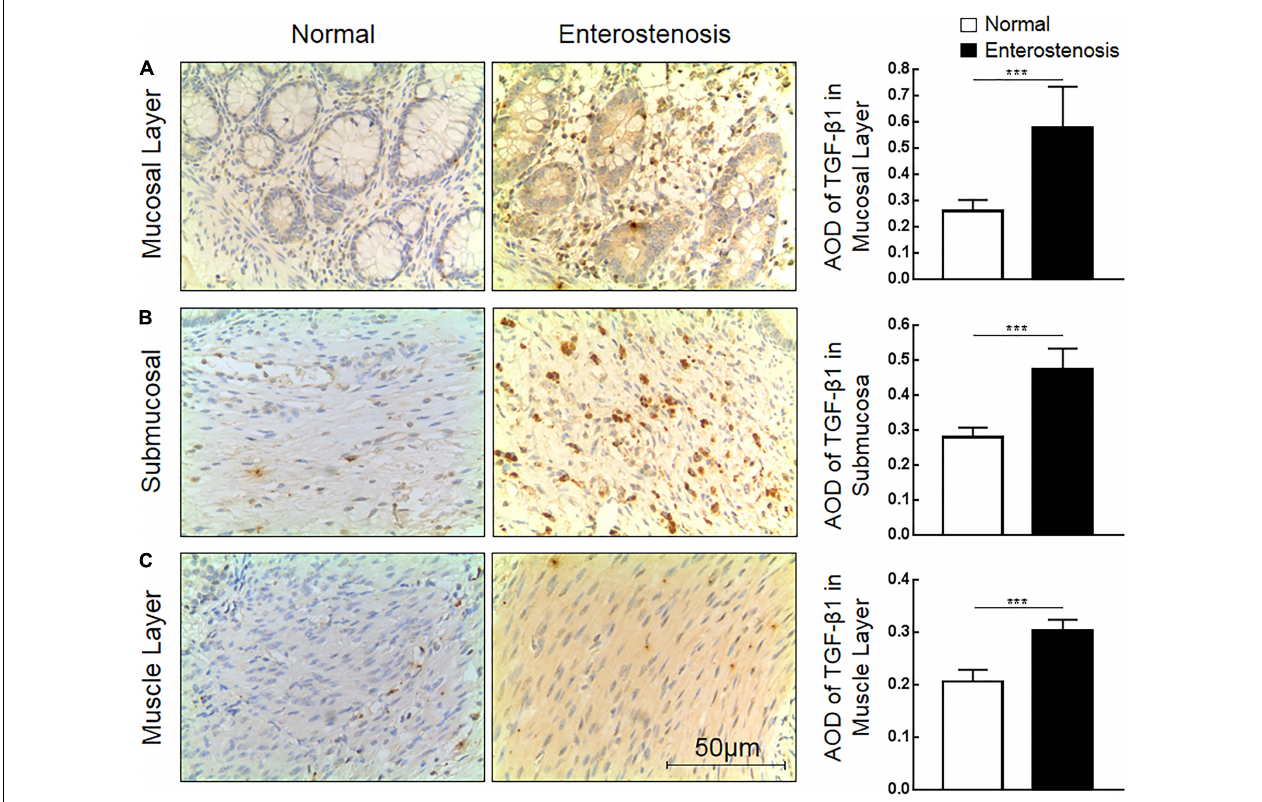
FIGURE 3 | The expression characteristics of transforming growth factor- β 1 (TGF- β 1) protein in post-necrotizing enterocolitis stricture tissue. (A) Expression of TGF- β 1 protein in the intestinal mucosal layer. (B) Expression of TGF- β 1 protein in the submucosa of the intestine. (C) Expression of TGF- β 1 protein in the muscularis of the intestine. (***Denotes the enterostenosis groups compared with the normal groups, n = 43, p <